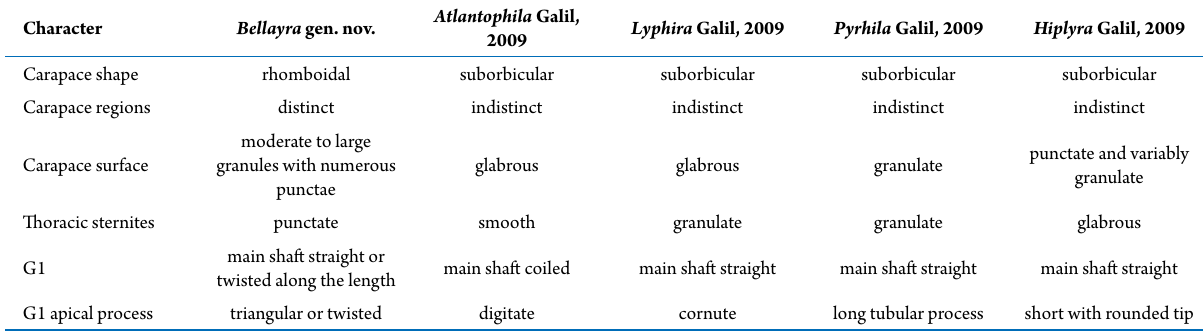
Table 1. Morphological comparison between Bellayra gen. nov. and its closely related genera (modified from Galil,